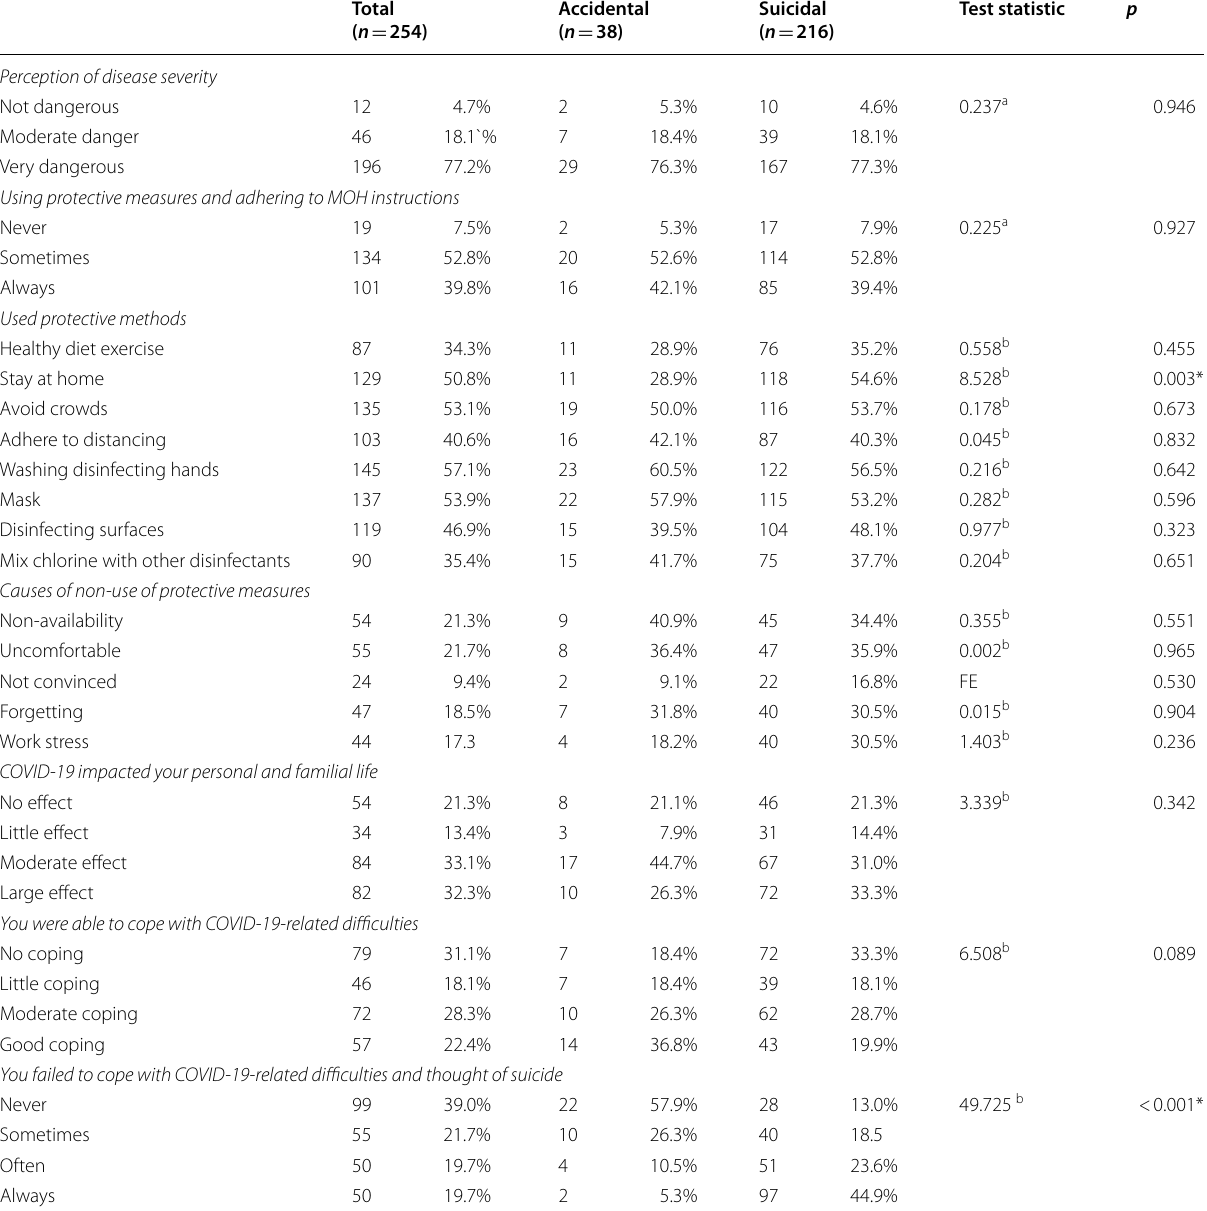
Table 3 Comparison of the attitude toward COVID‑19 pandemic between the studied groups ( n